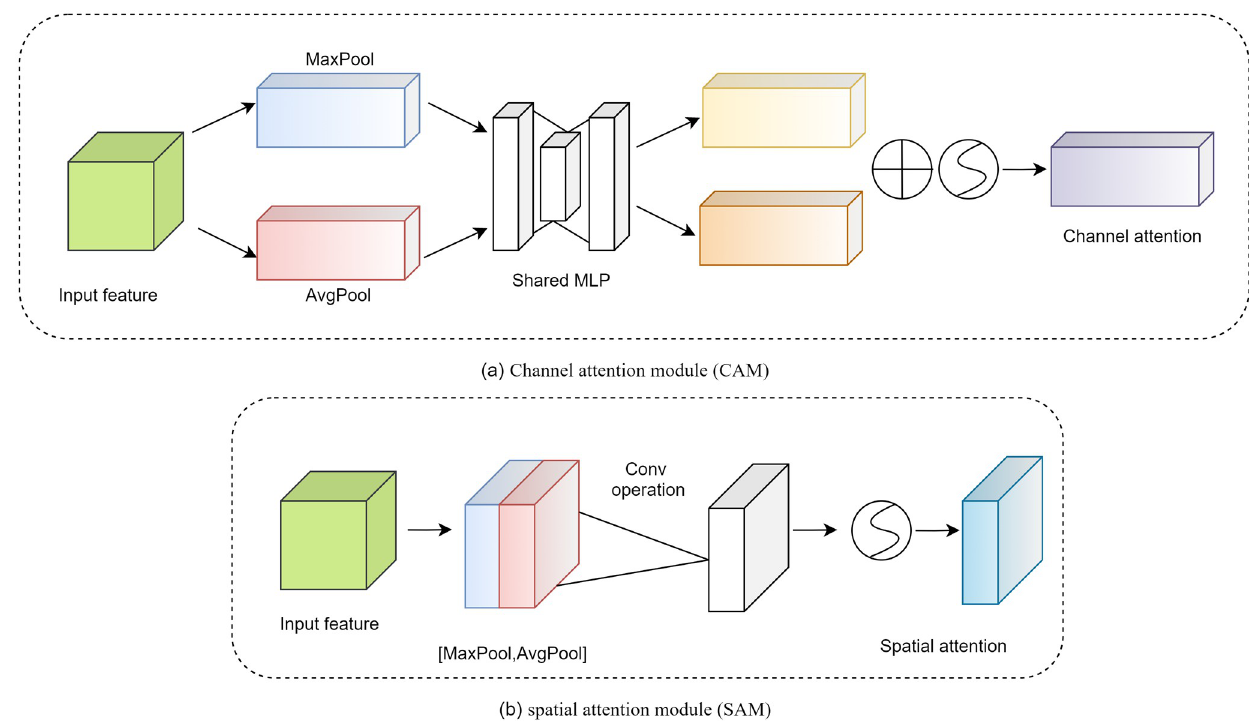
Fig 5. The structure of the Convolutional Block Attention Module (CBAM)